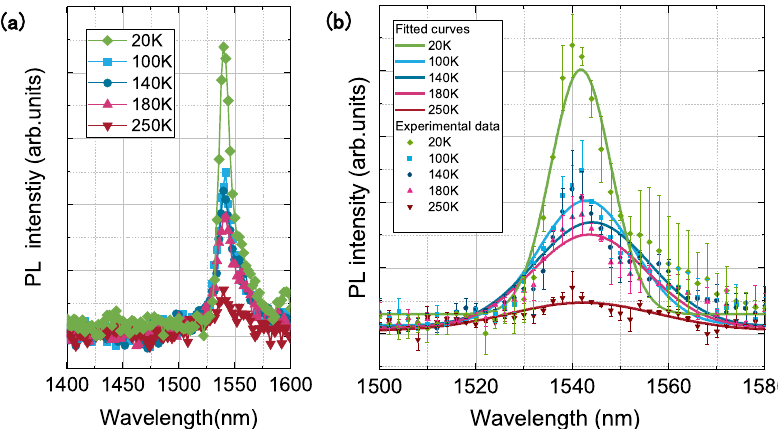
Fig. 2 Photoluminescence (PL) measurement results. a Temperature dependence of PL obtained from the device under excitation at 532 nm, and b magni fi ed and fi tted results shown in a , respectively. The curves were fi tted with a Gaussian distribution by minimizing the chi-square χ 2 and the error bars here represent one standard deviation (1 s.d.) of the fi tting errors.